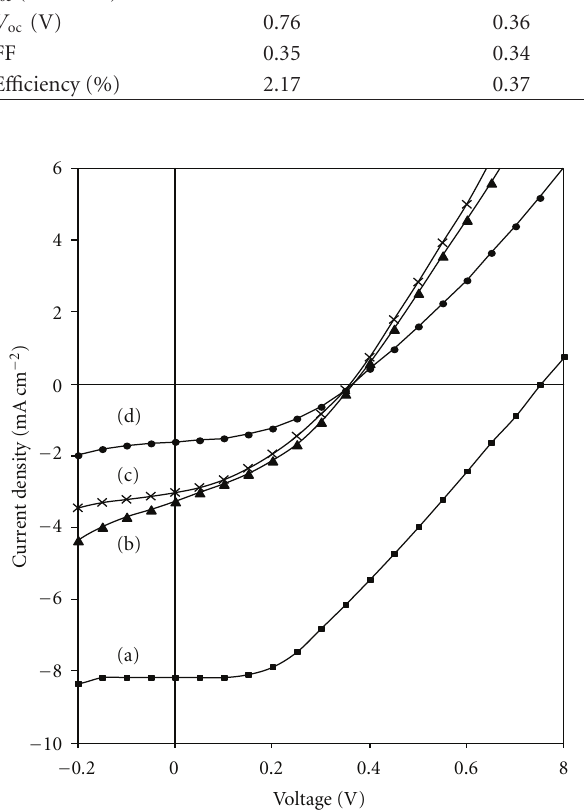
Figure 3: J - V curves for DSSCs with di ff erent dye materials. (a) Ruthenizer 535 (N3), (b) anthocyanin/chlorophyll mixture, (c) anthocyanin, (d)